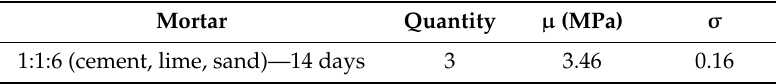
Table 9. Mortar compressive strength test results [39].